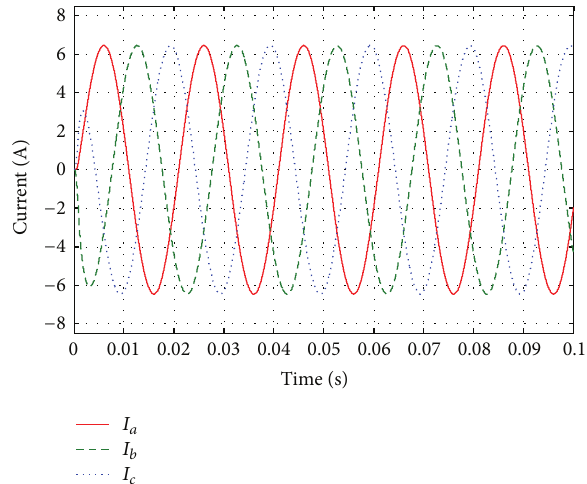
Figure18:Outputcurrentwaveforms(i.e., 𝐼 𝑎 , 𝐼 𝑏 ,and 𝐼 𝑐 )ofthethree- phase inverter with 𝑅𝐿 load.